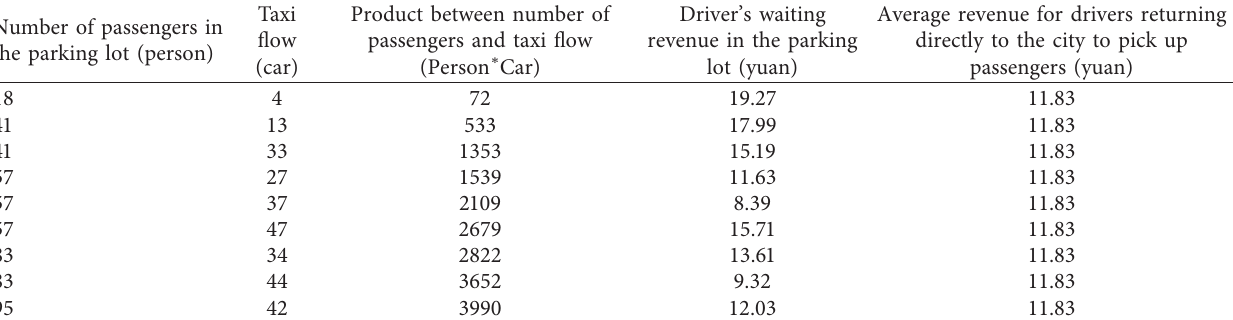
Table 4: The relationship between passenger flow and the driver’s revenue